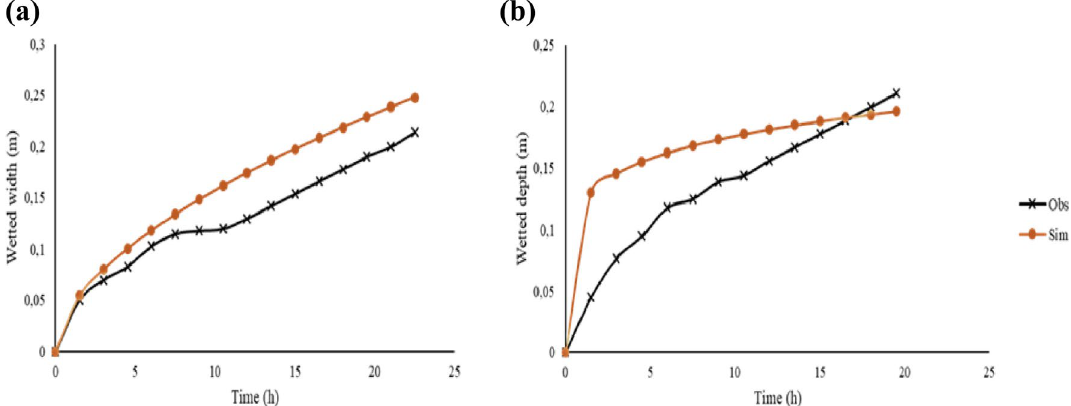
Figure 5. Observed vs simulated wetted distances for silty clay loam soil.